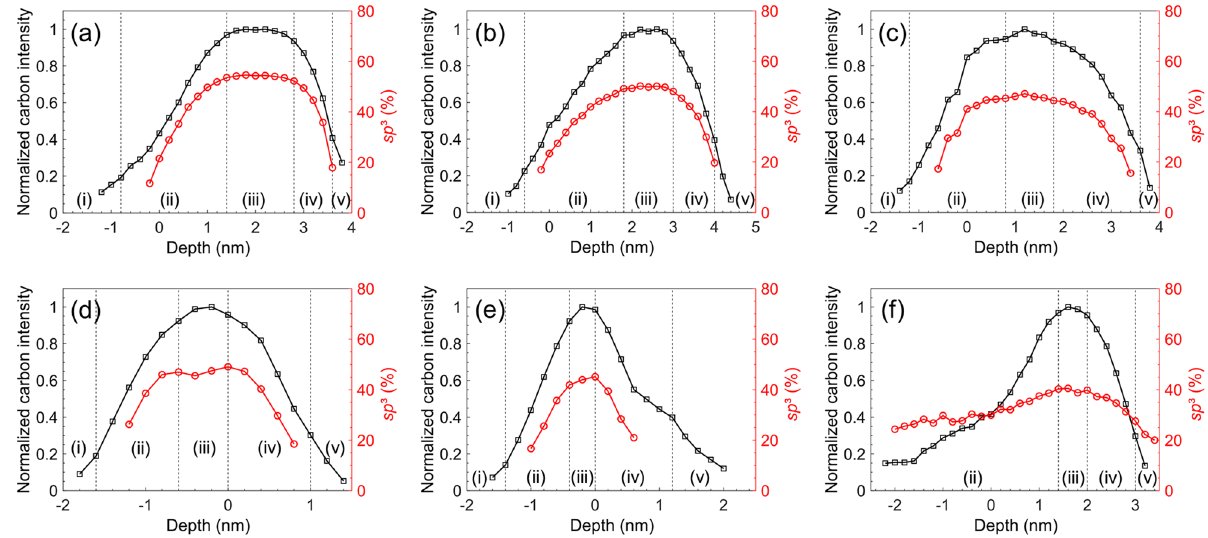
Figure 2. Depth profiles of normalized carbon intensity (black curves) and sp 3 fraction (red curves) obtained from the C K-edge EELS spectrum of a -C films in ( a – c ) a -C/Si and ( d – f ) a -C/SiN x /Si stacks obtained before RTA ( a , d ) and after RTA at 250 °C in Ar atmosphere for ( b , e ) 30 min and ( c , f ) 90 min. The EELS profiles reveal a layered cross-sectional structure consisting of (i) substrate (Si or SiN x ), (ii) intermixing layer, (iii) bulk layer, (iv) surface layer, and (v) capping layer (Cr).